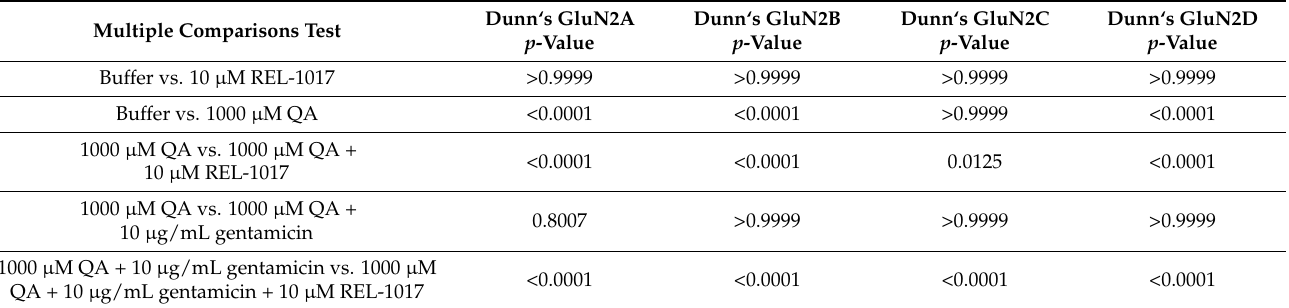
Figure 5. The 1000 µ M QA was a partial agonist at GluN1-GluN2A, GluN1-GluN2B, GluN1-GluN2C, or GluN1-GluN2D subtypes and 10 µ g/mL gentamicin did not increase [Ca 2+ ] in in the presence of 1000 µ M QA. REL-1017 significantly decreased [Ca 2+ ] in elicited by 1000 µ M QA or 1000 µ M QA plus 10 µ M gentamicin. Data ( n = 7 wells for buffer and REL-1017 groups, n = 42 wells for the remaining groups) are shown as scatter dot plot, and median value is indicated. **** is p < 0.0001; * is p < 0.05; ns, not statistically significant. Table 6. Statistical significance of values reported in Figure